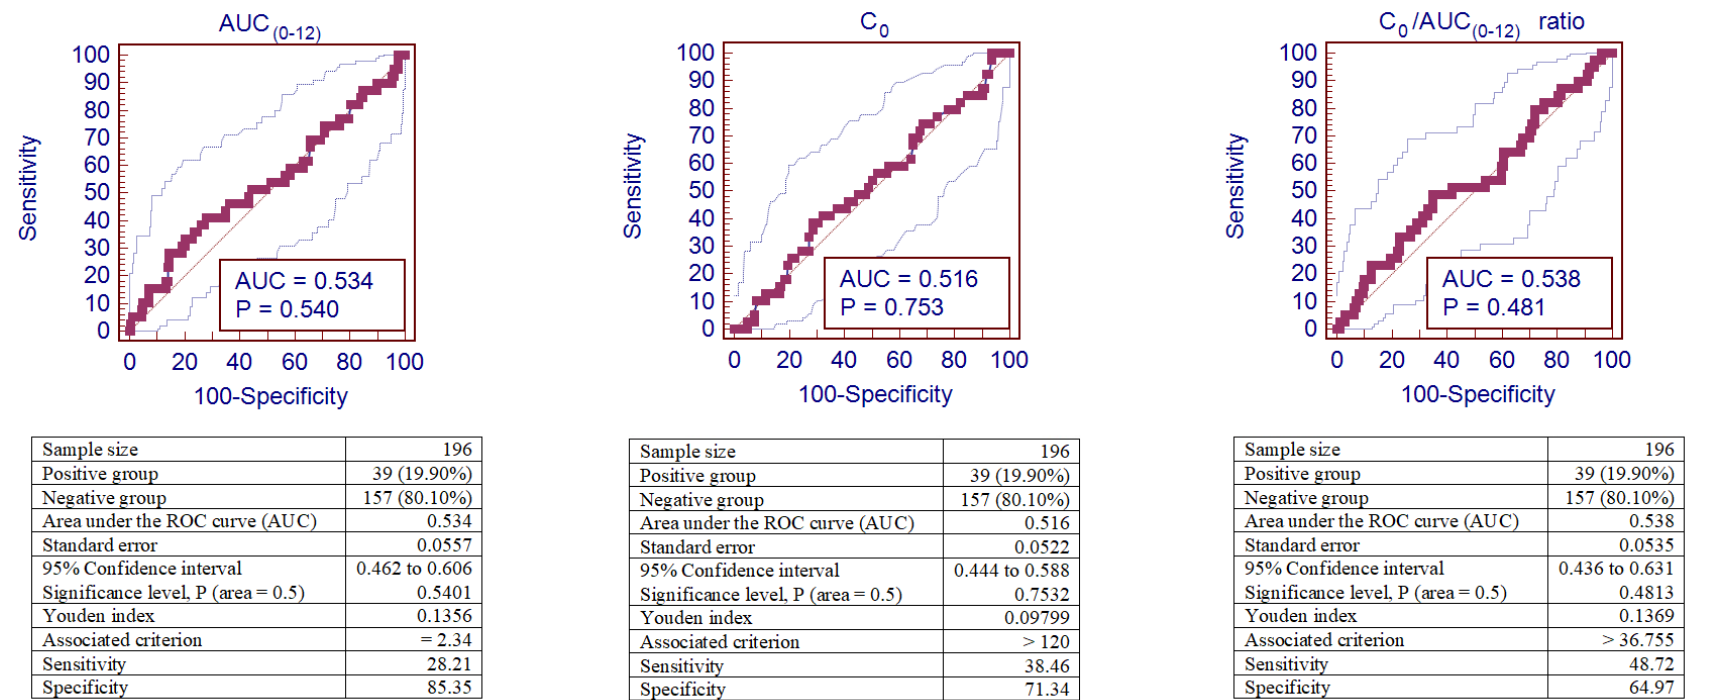
Figure 7. ROC curves of AUC (0–12) , C 0 , and the C 0 / AUC (0–12) ratio for CsA-induced IFTA. Analysis of sensitivity and specificity for IFTA represented by the ROC curves (area under the receiver operator curve—AUROC) in patients after kidney transplantation. IFTA—interstitial fibrosis and tubular atrophy.